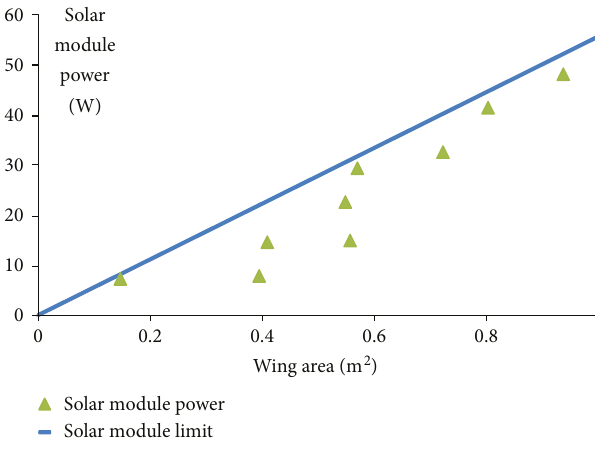
Figure 6: Wing area versus solar module power of the solar